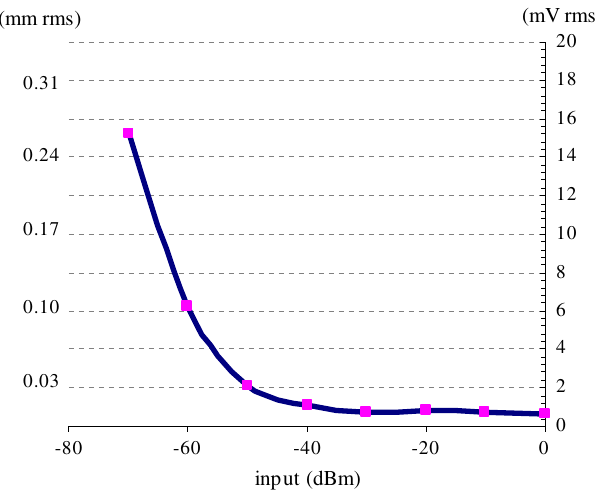
FIG. 12. (Color) The spatial resolution depends on the beam intensity. The right scale is the noise measured after the sampling of the output of the LR Bergoz module with the 6052 E PXI card. The left scale is the equivalent spatial noise for a chamber of 33 mm